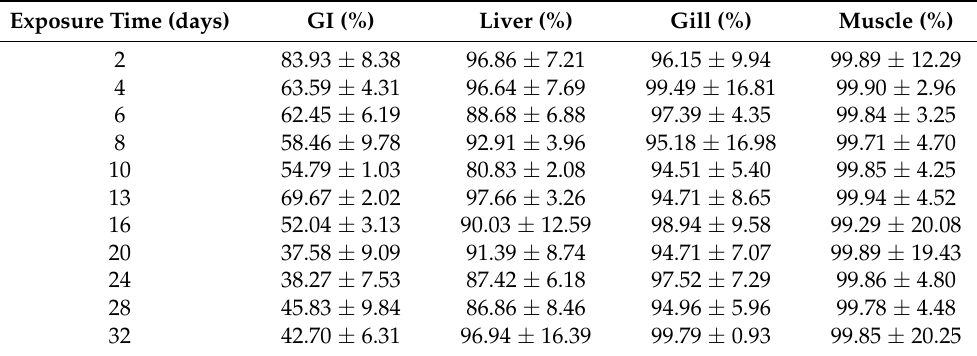
Table 2. The percentage of organic arsenic in different tissues for As(V)